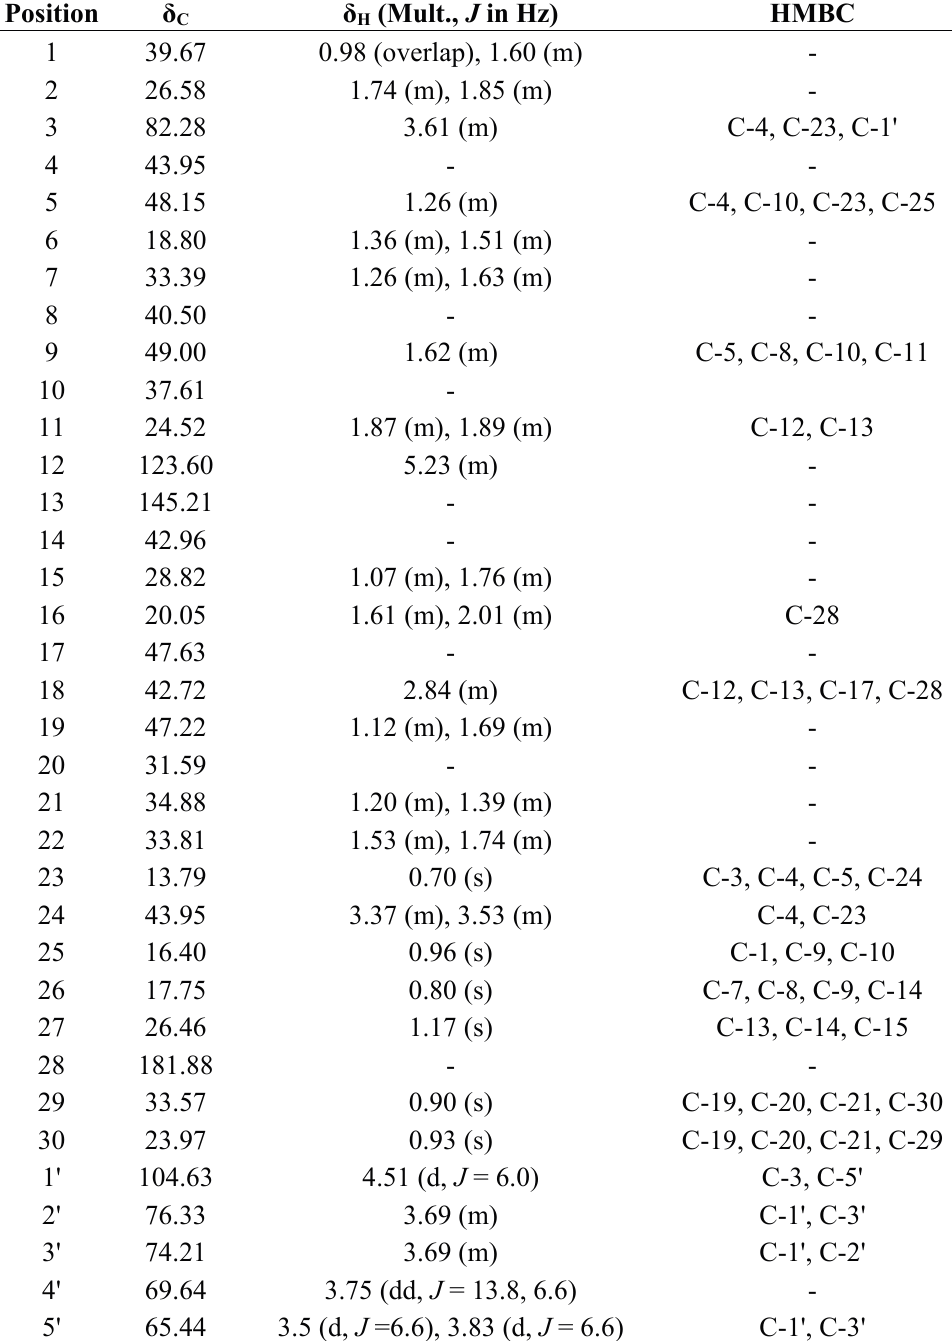
Table 1. The NMR spectroscopic data for clematoside-S ( 2 ) in MeOH- d 4 .